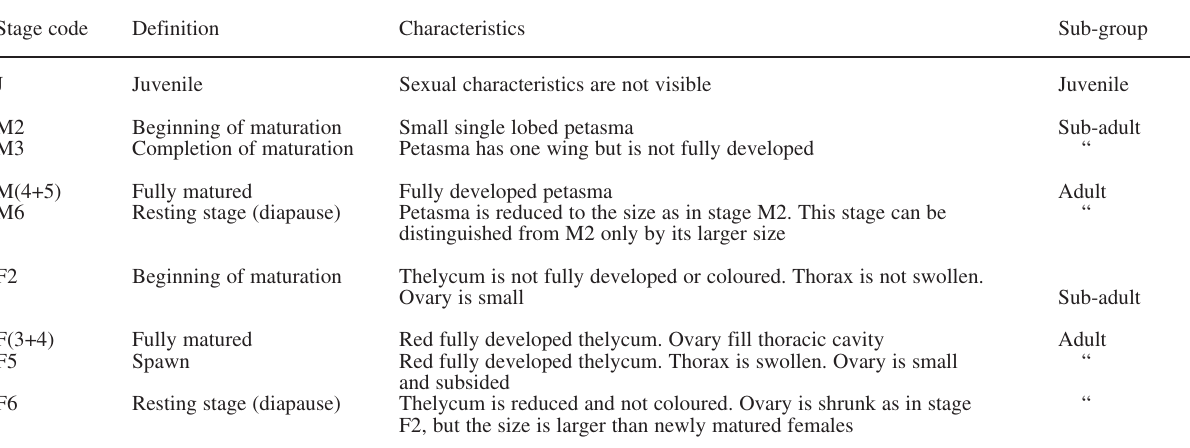
Table 2. – Euphausia superba . Reproductive Stage defined according to Makarov and Denys (1980). Stage